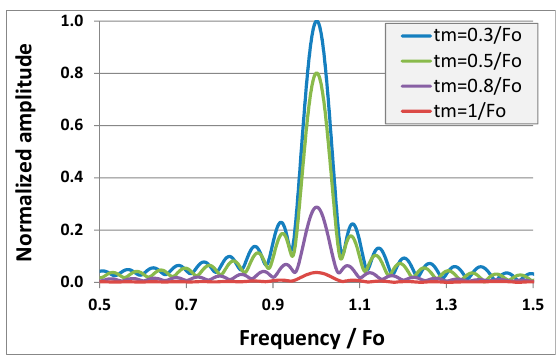
Figure 6. Amplitude of fundamental mode versus t m (Abaqus simulations results).